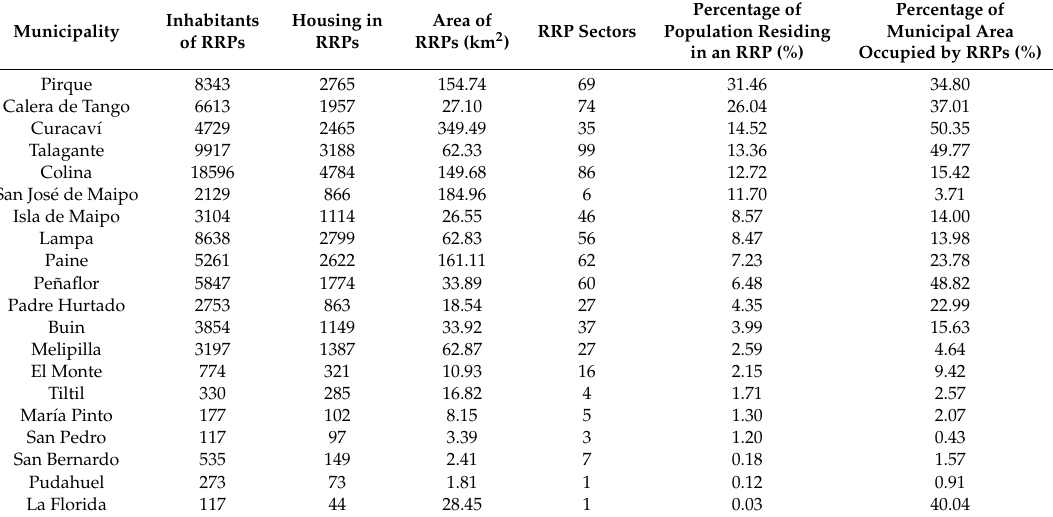
Table 1. Summary of census information on RRPs. Source: Own elaboration, based on INE (2017). Municipality